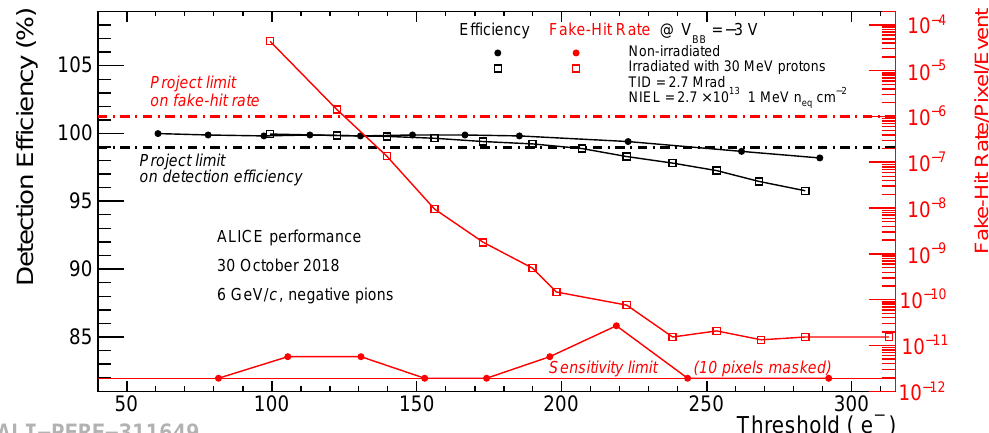
Figure 9. The detection efficiency and the fake-hit rate of the irradiated and non-irradiated ALPIDE sensors versus threshold charge for − 3V reverse substrate bias voltage. The detection efficiency was obtained using a 6 GeV/ c pion beam at CERN